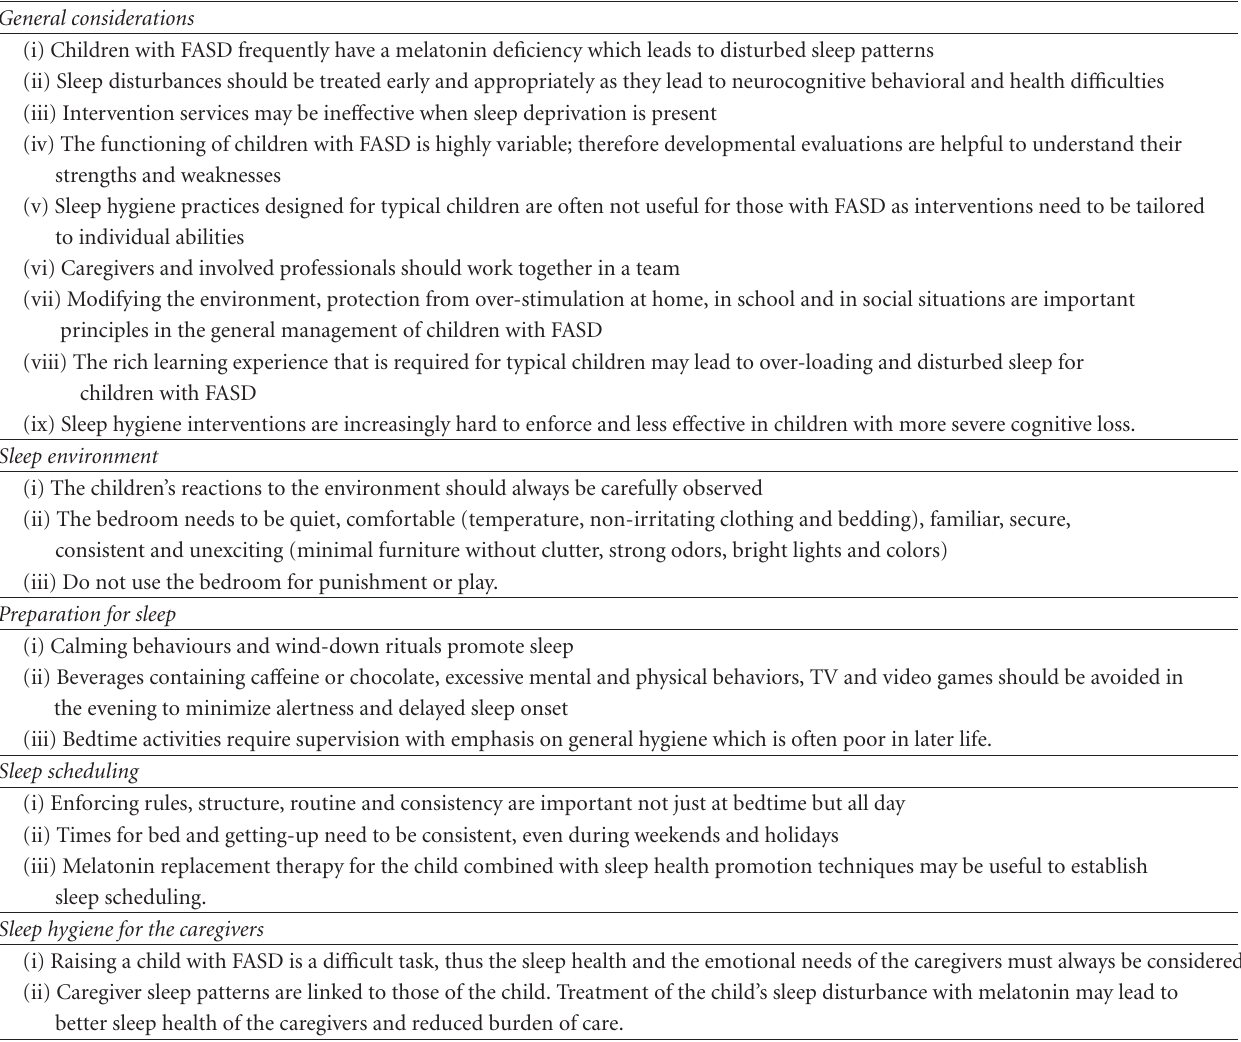
Table 1: Recommendations for Sleep